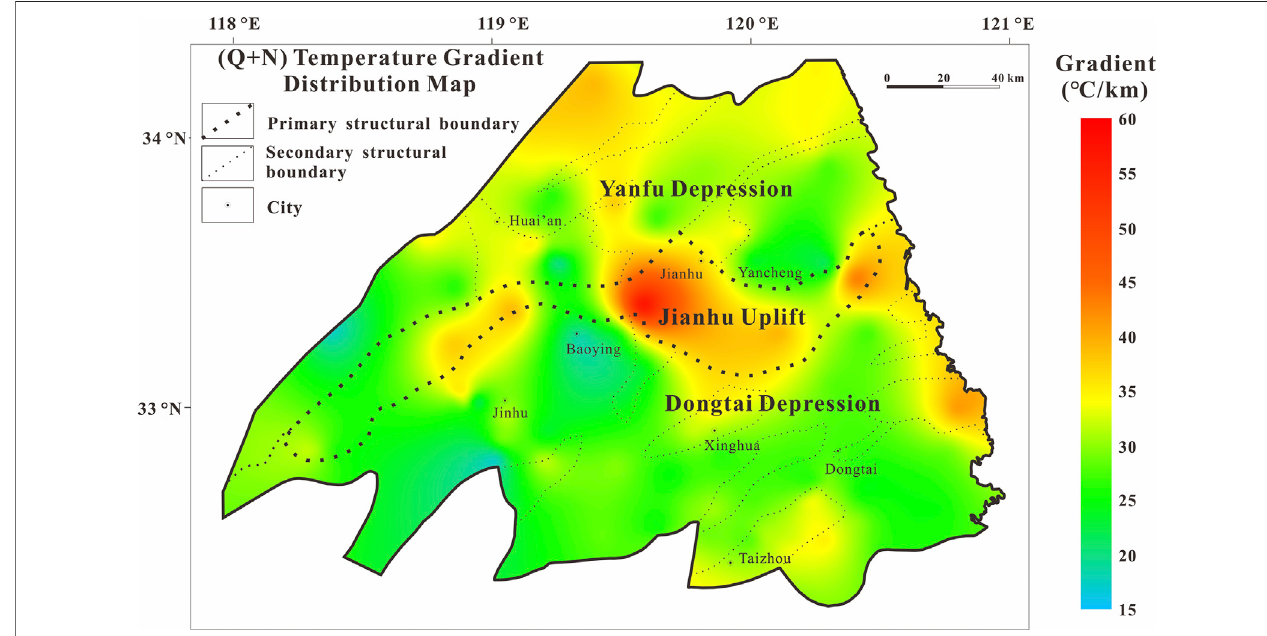
FIGURE 4 | Distribution of the (Q + N) temperature gradient in the North Jiangsu